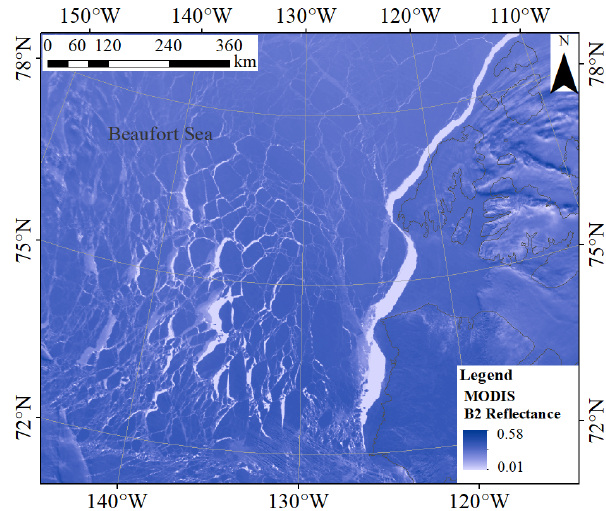
Figure 1. Location of the study area. The background image is the band 2 (B2) reflectance of a MODIS image acquired on 25 April 2015. The light-colored area represents